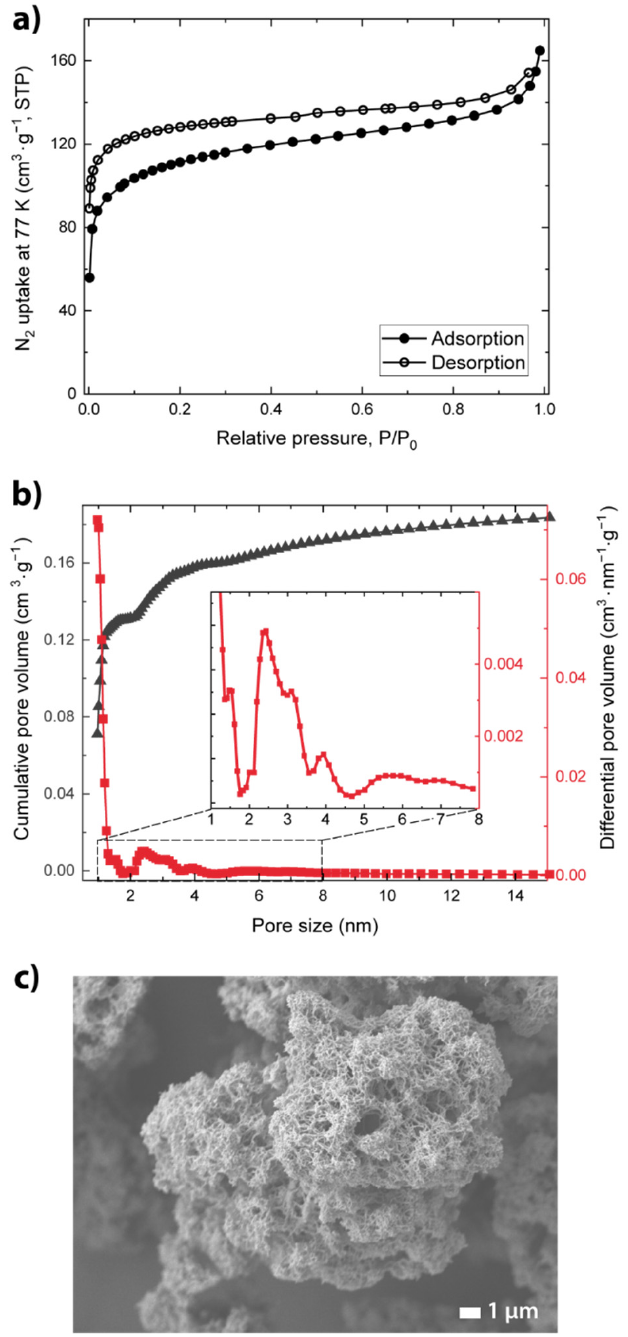
Figure 2. ( a ) Nitrogen adsorption and desorption isotherm of Per-TAPB-PPI . ( b ) Pore size distribution (i.e., pore size versus either cumulative pore volume (grey) or differential pore volume (red), including inset with zoom-in) of Per-TAPB-PPI calculated by a QSDFT model with the nitrogen adsorption isotherm input data. ( c ) SEM micrograph of Per-TAPB-PPI